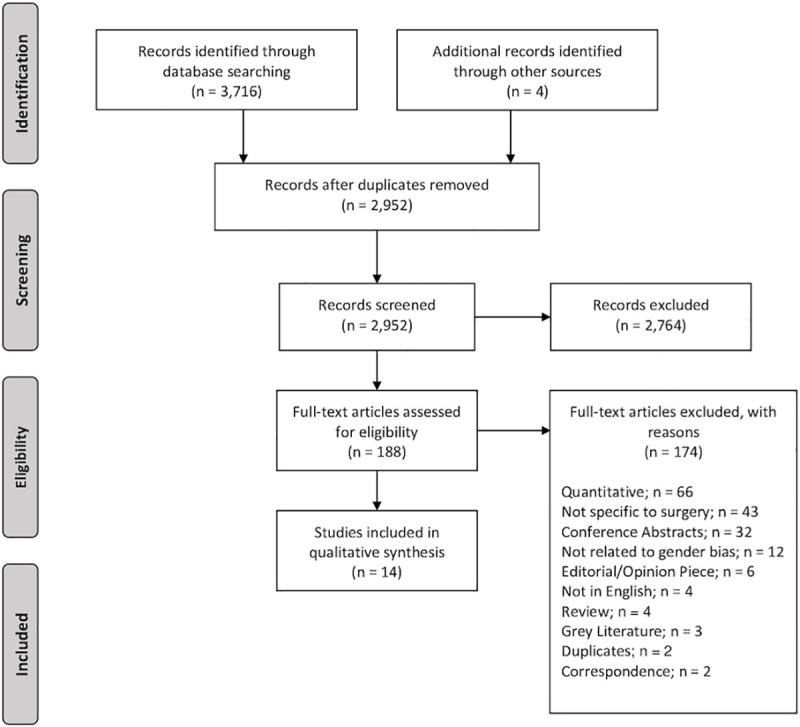
PRISMA flow diagram.